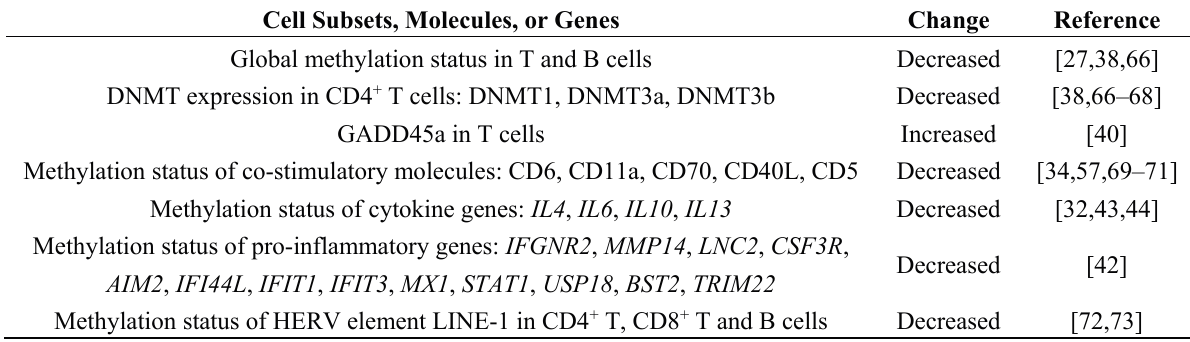
Table 1. DNA methylation status in immune cells of